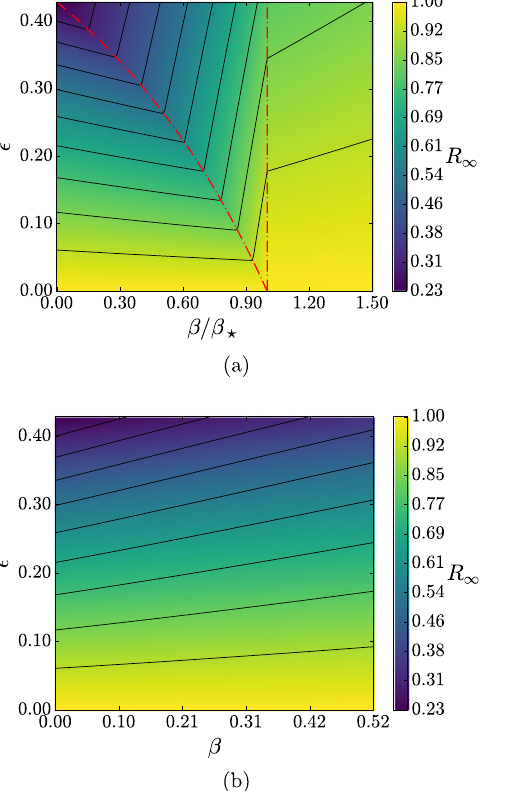
Fig. 4 Temperature-dependent bounds for magic distillation. Shown are two contour plots of the bound on R ( ϵ , β ) for the case P k k j i k h j and ϵ 0 ¼ 0 , where β is the inverse H ¼ H 0 ¼ k 2 Z 3 temperature and ϵ is the depolarizing error of the input magic state. The top fi gure ( a ) does not use any changes of Clifford basis, and the form of the bound depends on both the error parameter and temperature. The curved dashed line is ϵ ⋆ ( β ) and given by Eq. 86 in Supplementary Note 4 and β ? ¼ ð kT ? Þ (cid:3) 1 is given by E 2 (cid:3) ϕ ¼ kT ? ln2 . In the bottom fi gure ( b ) Clifford processing is used resulting in a smoother bound. In both fi gures the β = 0 line correspond to the unital bounds.